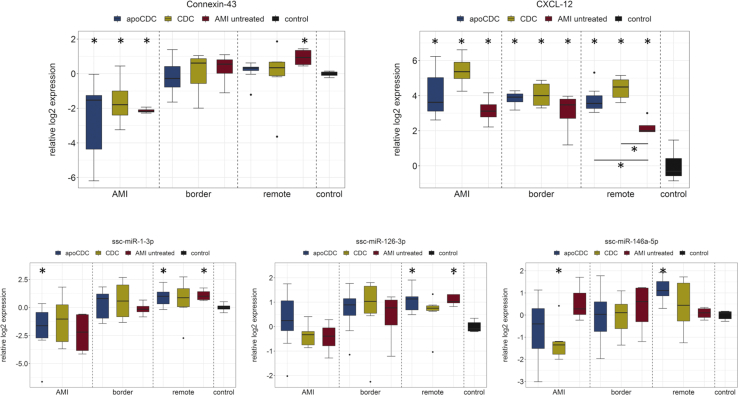
Analysis of Gene and miRNA Expression in Ischemic (AMI), Border, and Remote LV of Treated Pigs 1 Month after AMI and Receiving Stem Cell TreatmentControl represents healthy (non-AMI) heart tissue. ∗p < 0.05 (ANOVA with Bonferroni post hoc) compared to healthy animals; compared to untreated where indicated.